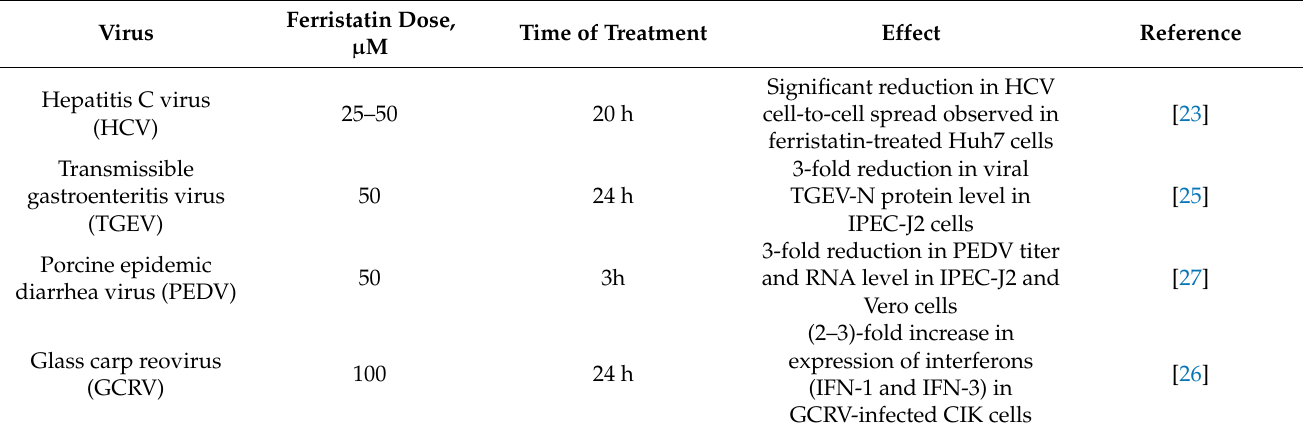
Table 1. Examples of ferristatin II effects on the replication of human and animal